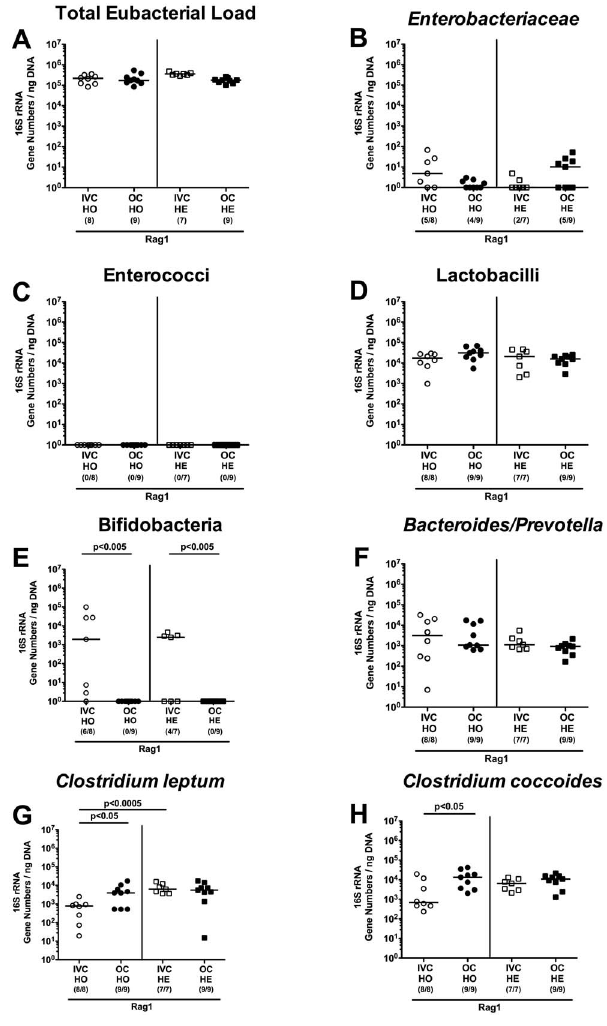
Figure 7. Commensal intestinal microbiota composition of Rag1 deficient mice kept in IVC or open cages. After eight weeks of housing of homozygous (HO; circles) or heterozygous (HE; squares) Rag1 gene-deficient mice in IVC (white symbols) or open cages (OC; black symbols), 16S rRNA of main intestinal bacterial groups was quantified in individual fecal samples. ( A ) Total eubacterial loads and quantitative abundance of ( B ) Enterobacteriaceae , ( C ) enterococci, ( D ) lactobacilli, ( E ) bifidobacteria, ( F ) Bacteroides/Prevotella spp., ( G ) Clostridium leptum group, and ( H ) Clostridium coccoides group are expressed in gene numbers per ng DNA. Medians (black bars), levels of significance ( P -values) determined by the Mann-Whitney-U test and numbers of analyzed animals (in parentheses) are